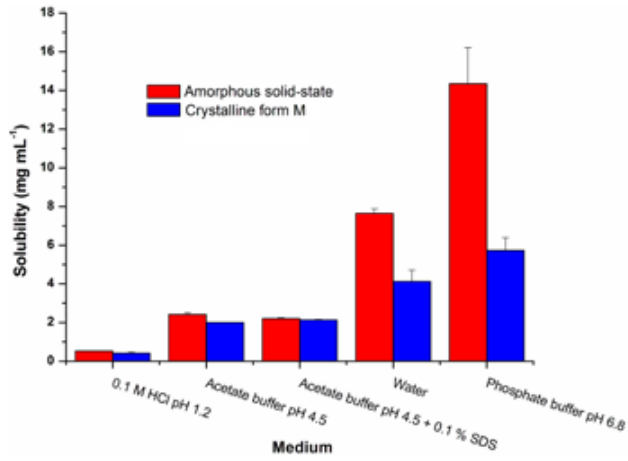
FIGURE 5 - Solubility of ROSC in aqueous media at 37°C